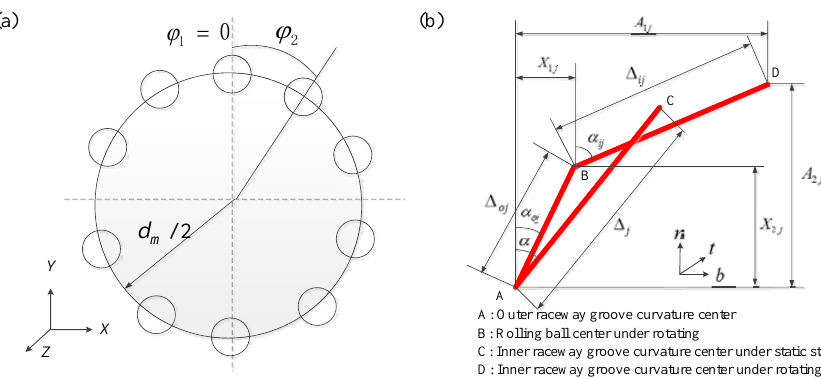
A: Outer raceway groove curvature center B: Rolling ball center under rotating C: Inner raceway groove curvature center under static state D: Inner raceway groove curvature center under rotating